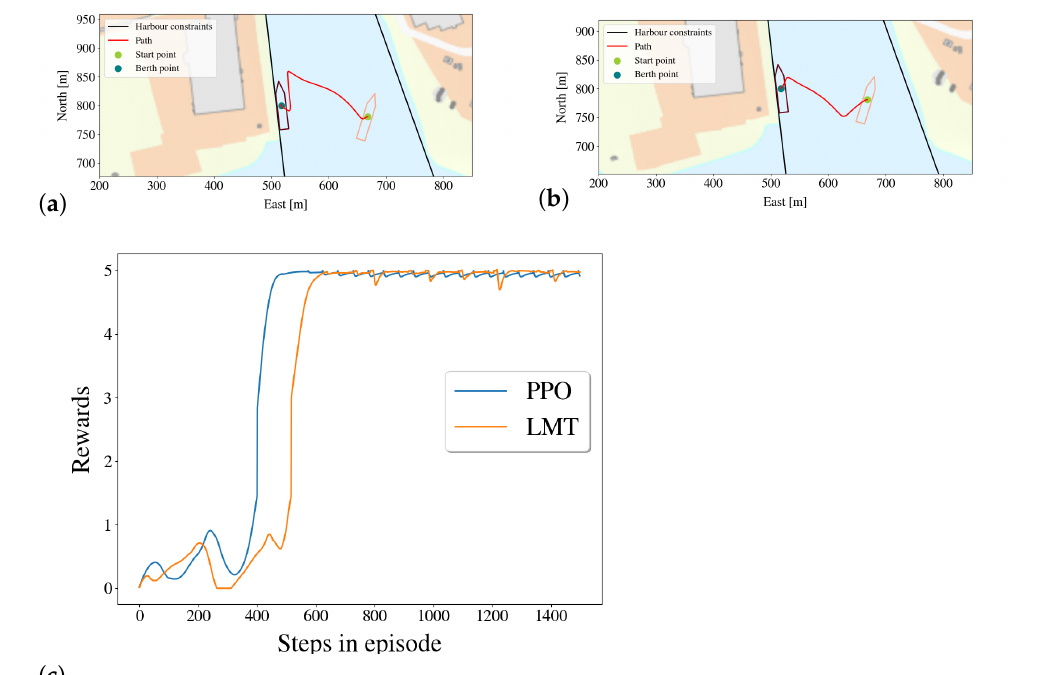
Figure 12. ( a ) A successful run by the LMT OFS 312, ( b ) a successful run by the PPO-policy, and ( c ) the LMT’s and PPO-policy’s rewards for their respective runs with the same starting